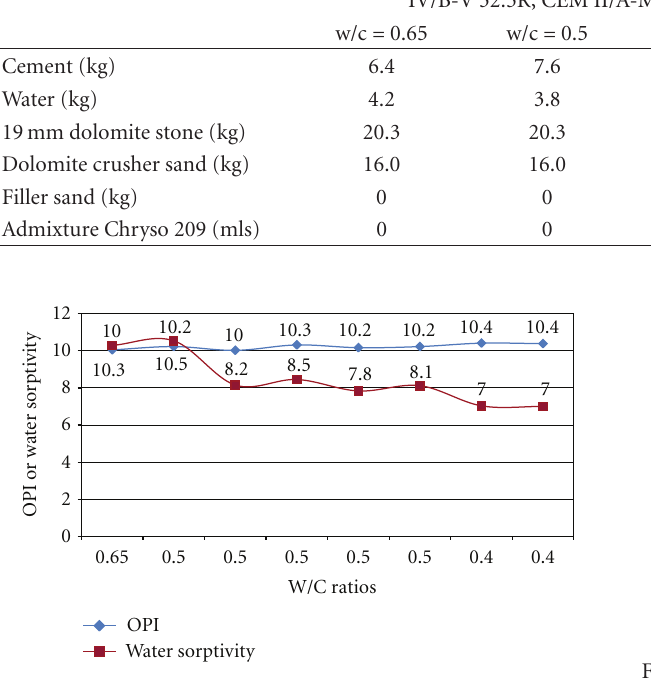
Figure 2: OPI and water sorptivity results for CEM I 42.5N at dif- ferent w/c ratios.